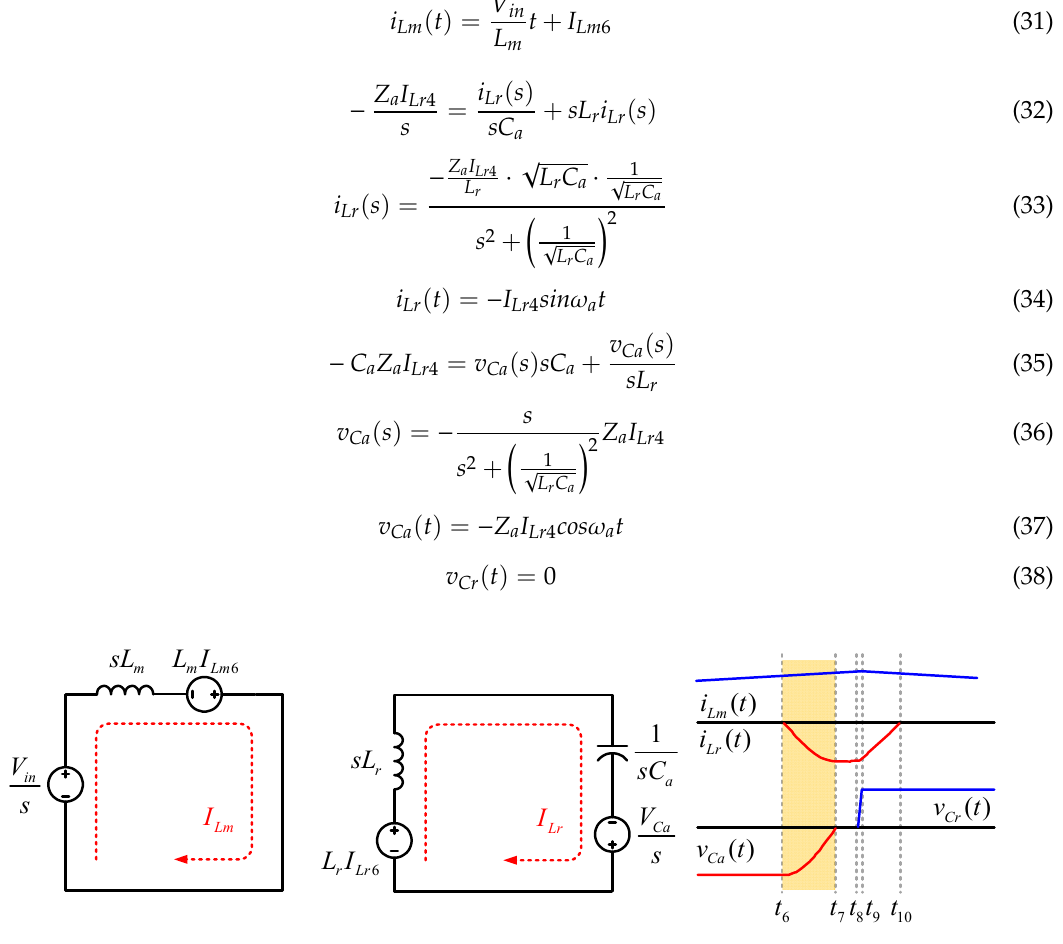
Figure 10. The equivalent circuit of Mode 7 and key waveform.